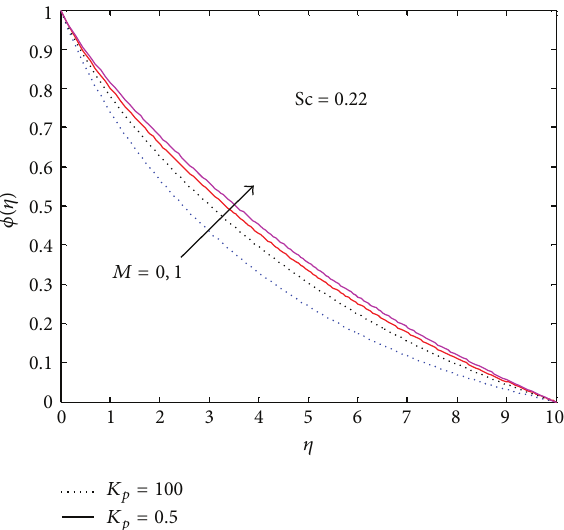
Figure 7: Concentration distribution for 𝑀 and 𝐾 𝑝 .